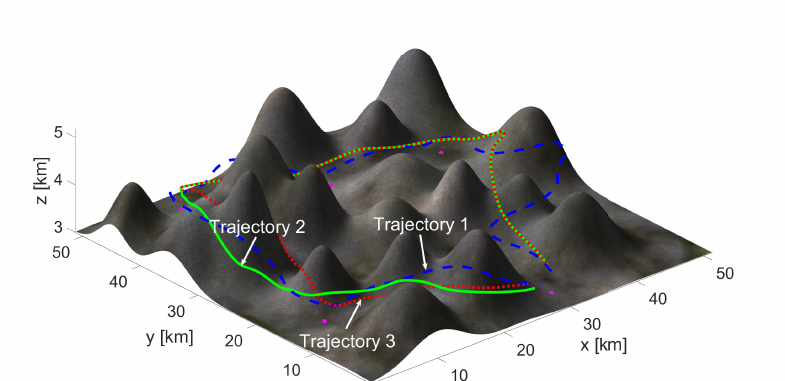
Figure 10. The UAV trajectories by Algorithms 1, 2, and